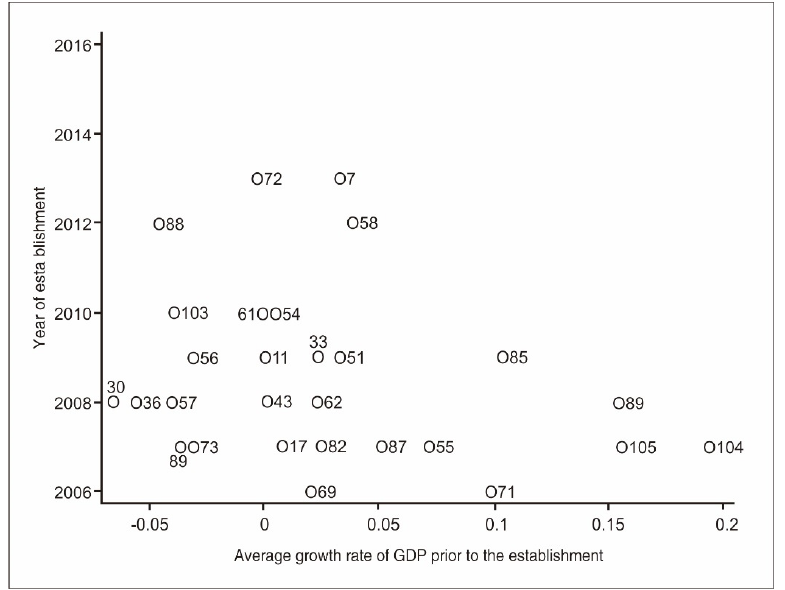
Figure A1. The development of GDP: Guangxi and the national average.